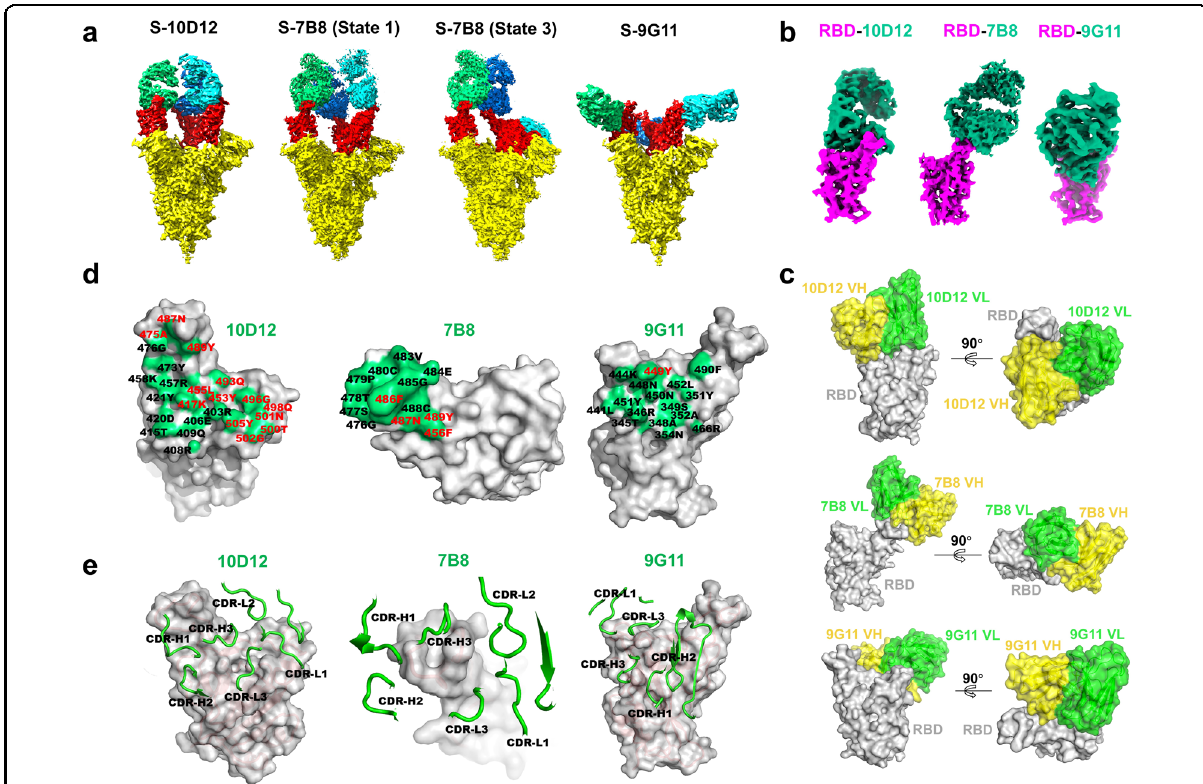
Fig. 2 Cryo-EM structures reveal the binding interface between the three neutralizing antibodies and the SARS-CoV-2 S trimer. a Overall structures of trimeric SARS-CoV-2 S protein in complex with three antibodies. The RBD domain is shown as red, and Fab is shown as cyan/blue/green. b The cryo-EM map of a single Fab fragment bound to RBD after local re fi nement. The RBD domain is shown as magenta, and Fab is shown as green. c Side (left) and top (right) views of the cartoon representation of antibody VH (yellow surface) and VL (green surface) bound to RBD (gray surface). d The footprint of Fab on SARS-CoV-2 RBD is colored as a green surface and the corresponding epitopes on RBD are labeled as red (overlapped with hACE2) or black (not overlapped with hACE2). e CDR loops of Fabs overlaid on a surface representation of the RBD (gray surface) show the interaction between Fab and